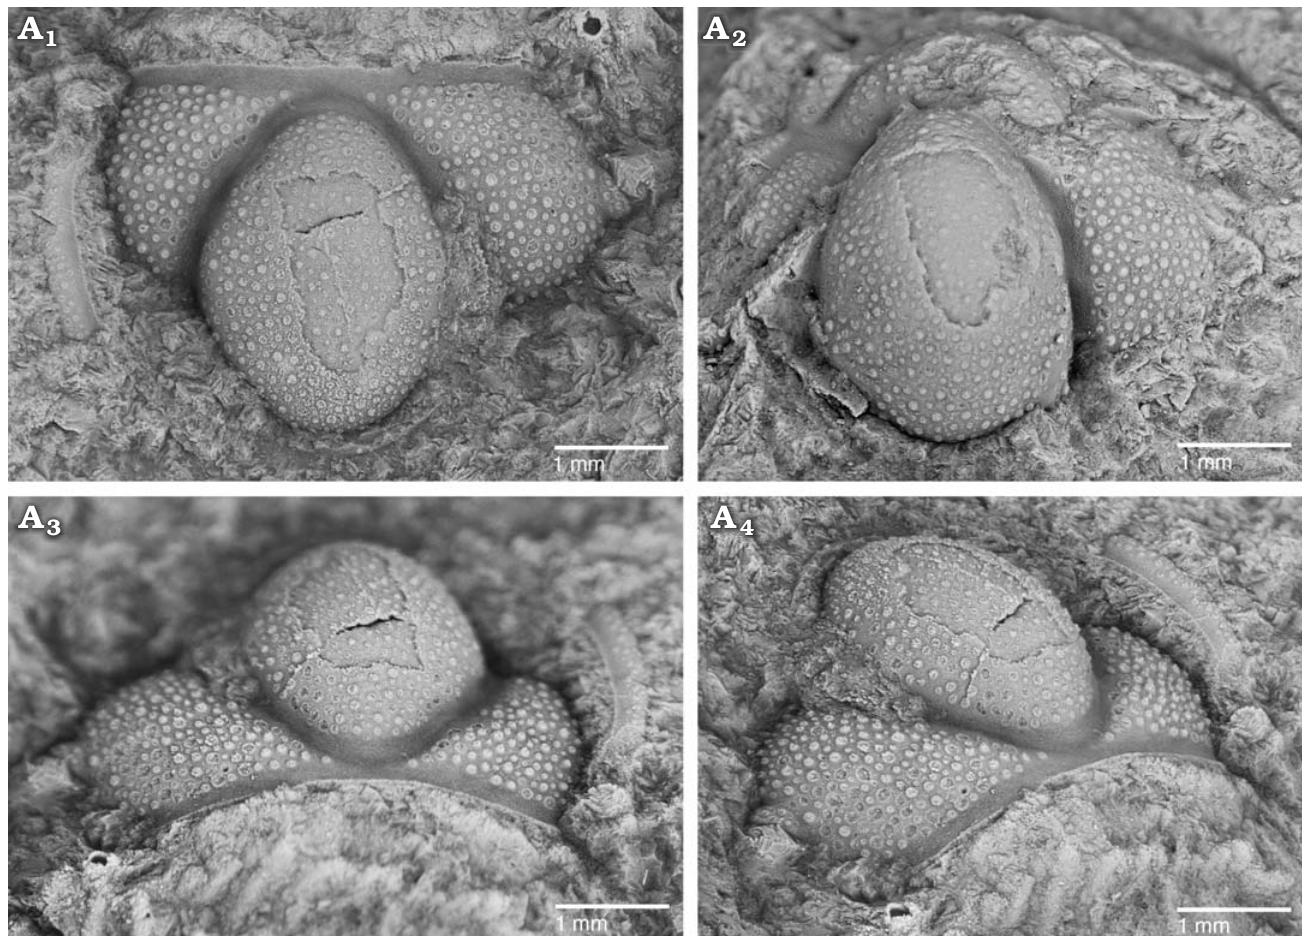
Fig. 3. The solenopleurid trilobite Trachoparia ? sp. from the lower Cambrian White Point Conglomerate, Kangaroo Island, South Australia. Latex cast of partial cranidium (SAM P57221) showing pustulose ornament and strongly tapered glabella in dorsal (A 1 ), anterior (A 3 ), and oblique anterolateral (A 4 ) views; testate cranidium in dorsal view (A 2